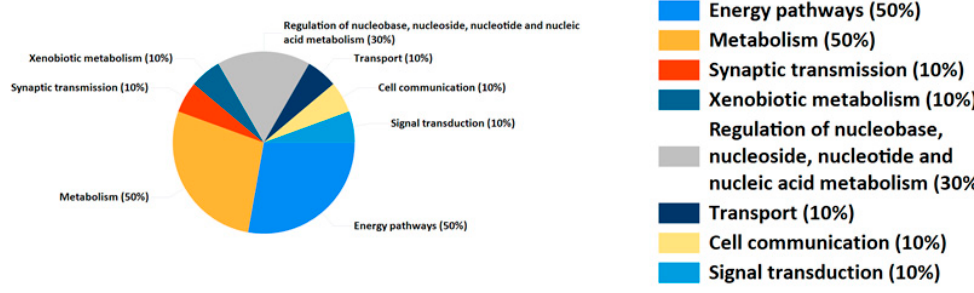
Figure 8. Pathway enrichment analysis of network pharmacology. 3. Discussion As is well known, the main manifestations of prostatitis exhibited a pain in the pelvic region and dysfunction of urination. The main manifestations of pain exhibited anxiety, tachypnea, hypertension, hyperhidrosis and etc. It is interesting to note that the increasing of VO 2 and VCO 2 in this study might be caused by tachypnea, so as to promote the degree of H and EE and decrease RER. However, the flavonoids constituent and polysaccharides constituent of T. patula could reverse those. In addition, the increasing of Na + /K + -ATPase’s activities in prostate and liver also reflected that the flavonoids and polysaccharides of T. patula could regulate energy metabolism.